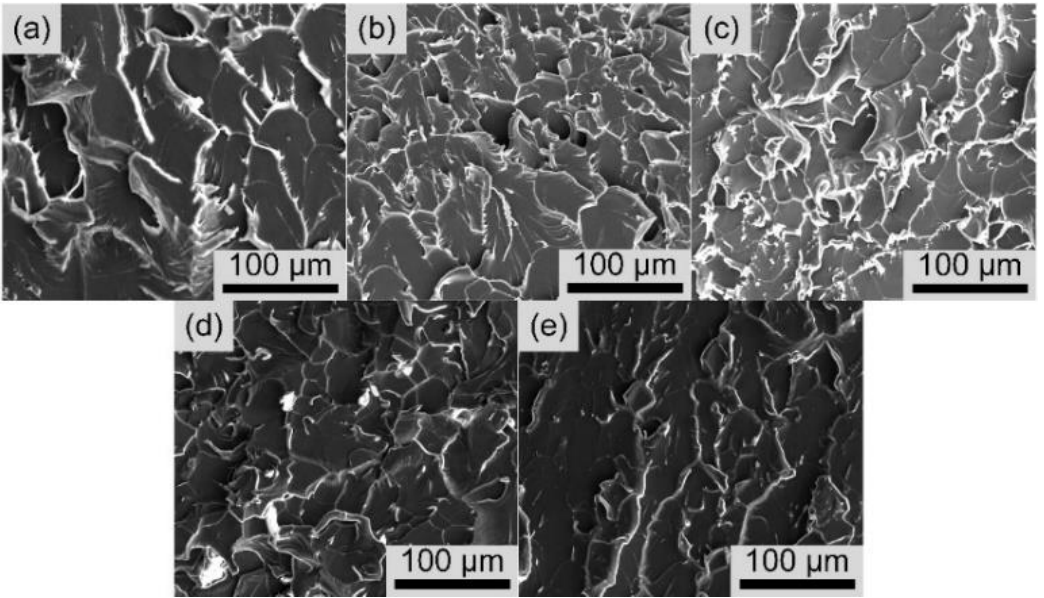
Figure 9. SEM fractographs of the epoxy nanocomposites with 0.05 wt%: ( a ) p-MWNTs, ( b ) B1@ f MWNTs, ( c ) B2@ f MWNTs, ( d ) B3@ f MWNTs, ( e ) B4@ f